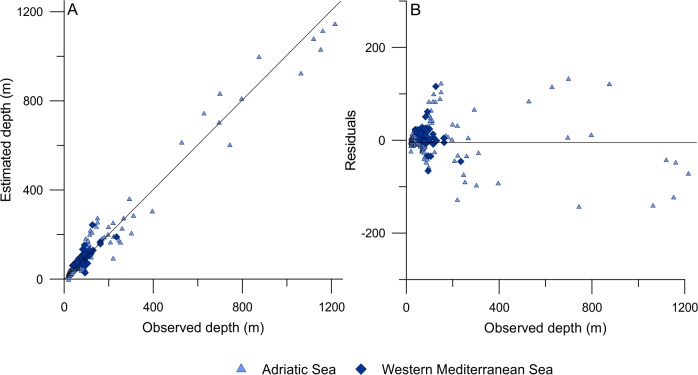
Transfer function performance.Shown are the observed versus estimated water depths (A) and their residuals (B) in the combined modern data set (different colors and symbols are given for the two modern data sets from the Adriatic and Western Mediterranean Seas). See also Table 2.